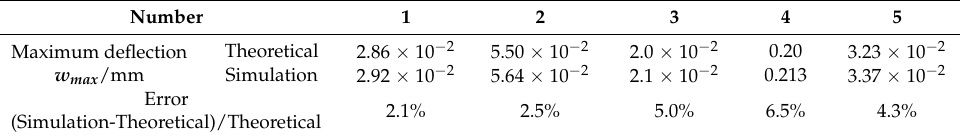
Table 4. The maximum deformation and error between theoretical results and simulation results.